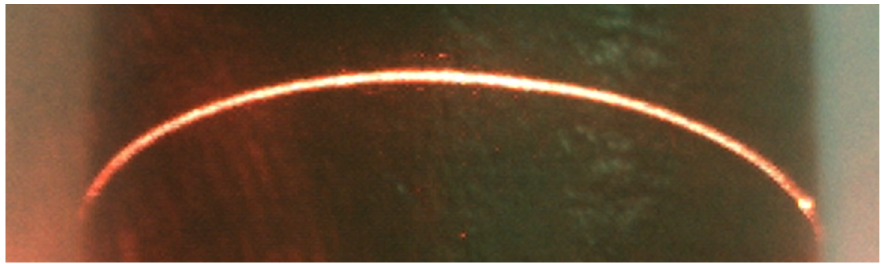
Figure 15. Curve laser stripe. Table 4. The 𝑅𝑀𝑆𝐷 difference of each algorithm for curve.